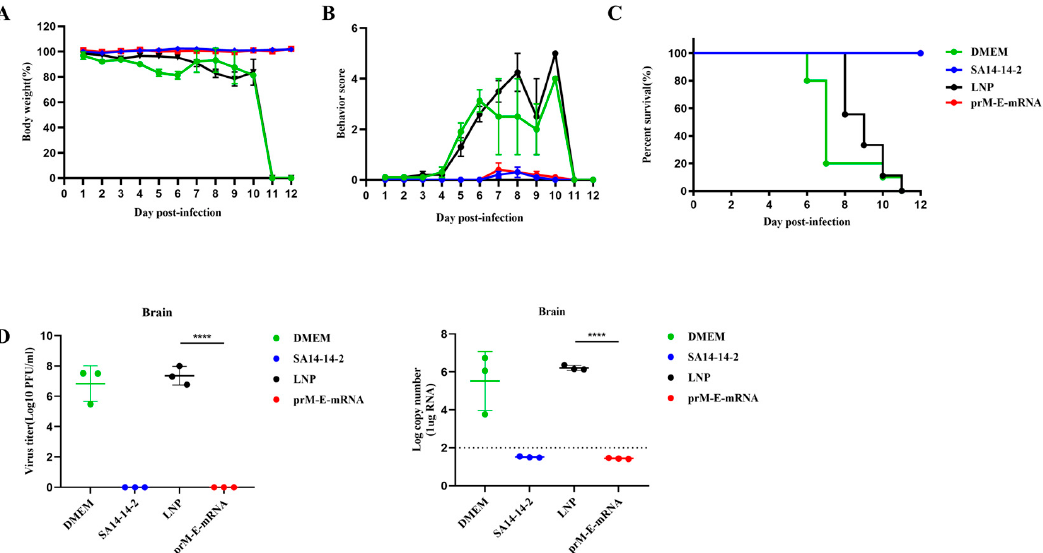
Figure 3. Protective efficacy against JEV in C57BL/6 after immunization. Body weight changes ( A ), behavioral score ( B ) and survival rate ( C ) were recorded after JEV P3 strain challenge. Survival rate is displayed as Kaplan–Meier survival curves and behavioral changes from normal to severe are represented on a scale of 0 to 5 ( n = 10). ( D ) Viral loads in mice brain were detected by plaque assay and qRT-PCR at day 5 after JEV-infection. Data are represented as mean ± SEM. ( n = 3, **** p < 0.0001).